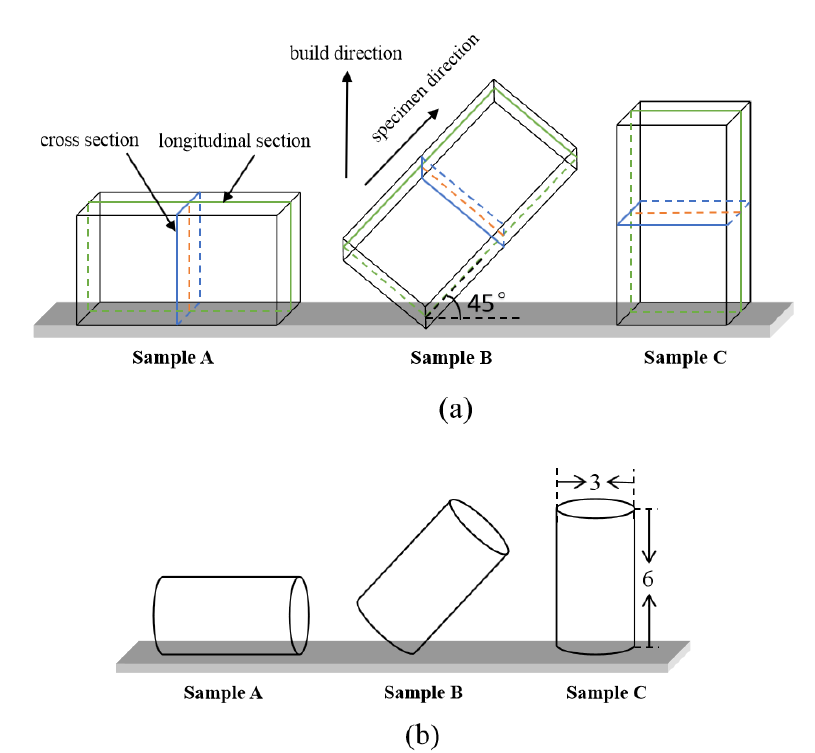
Figure 3. Strategy of manufacturing of the sample A, B, and C: the cubic specimen for electrochemical measurements ( a ) and the cylindrical specimen for compression tests ( b